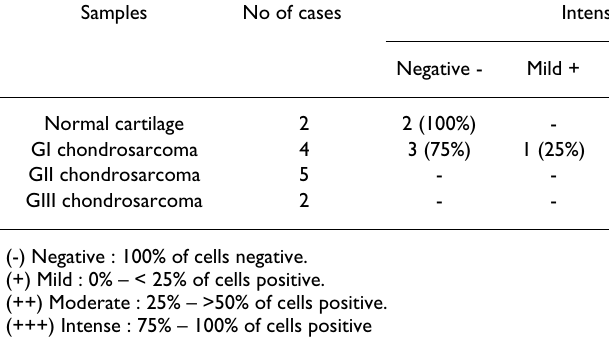
Table 1: Immunohistochemical staining reaction for MMP-13 in normal cartilage and chondrocarcomas.